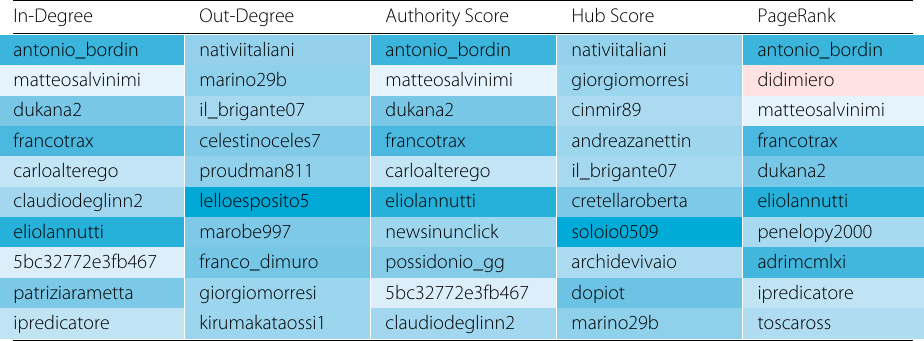
In-Degree Out-Degree Authority